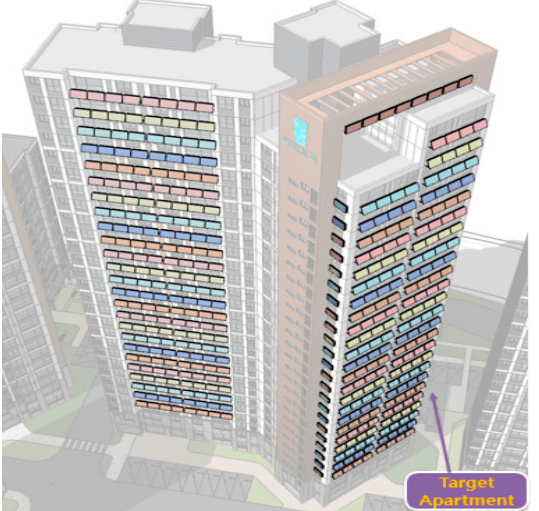
Figure 7. The perspective view with the color MB-BIPVS on the south side of the target apartment.